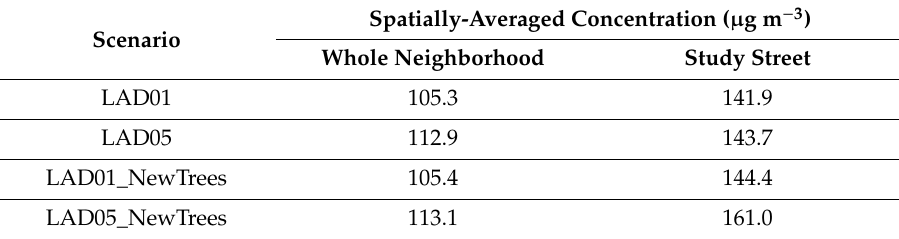
Table 2. Spatially-averaged concentration at 3